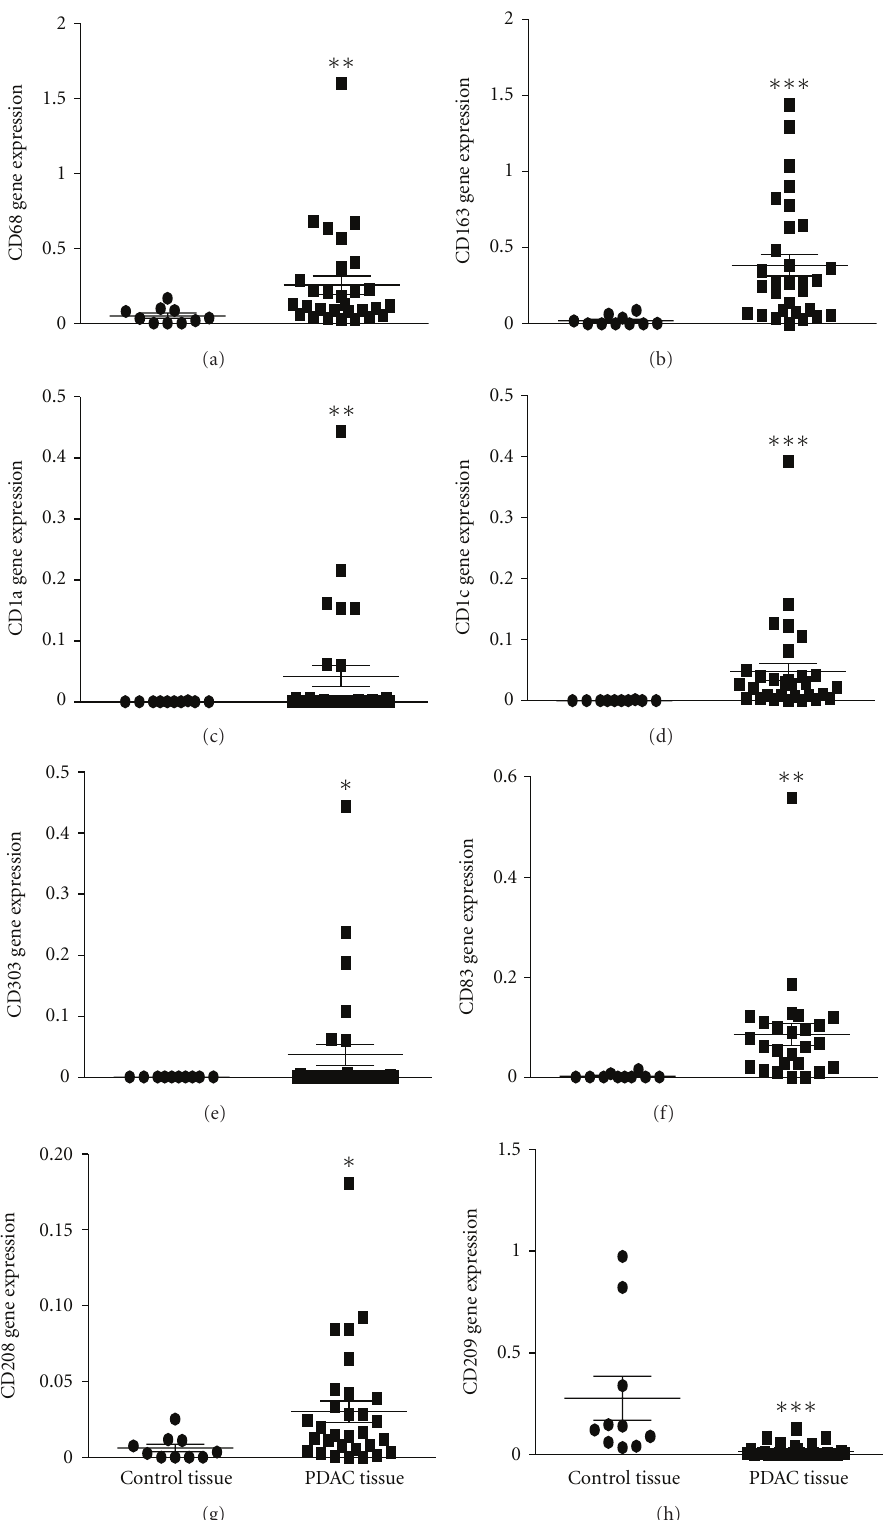
Figure 4: Elevated gene expression levels of markers of infiltrating immune cells in PDAC tissue. RNA was obtained from PDAC ( n = 30) and normal pancreatic tissue samples ( n = 10) and assessed for relative gene expression levels of markers expressed by (a and b) macrophages (CD68 and CD163), (c and d) myeloid dendritic cells (CD1a and CD1c), (e) plasmacytoid dendritic cells (CD303), and (f–h) DC maturation/activation status markers (CD83, CD208 and CD209). ∗ P < 0 . 05, ∗∗ P < 0 . 05, ∗∗∗ P < 0 .